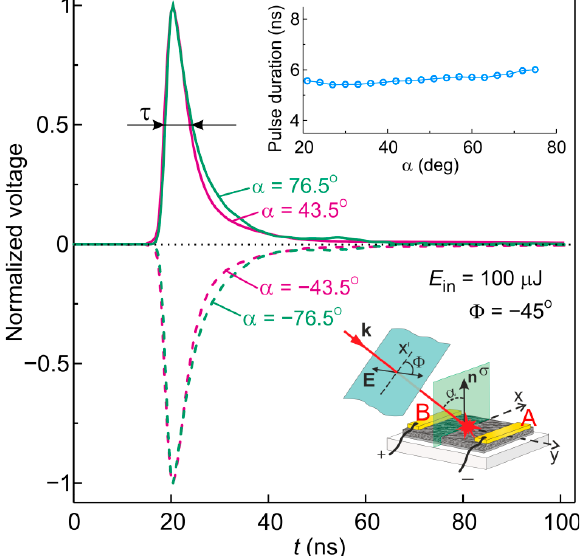
Figure 4. The waveforms of the transverse photovoltage pulses normalized to their extreme values at linear polarization ( Φ = − 45 ° ), recorded at positive (solid lines) and negative (dashed lines) angles of incidence α . The upper inset shows the dependence of the recorded pulses duration τ on the angle of incidence. The bottom inset shows the sketch of the experimental setup.